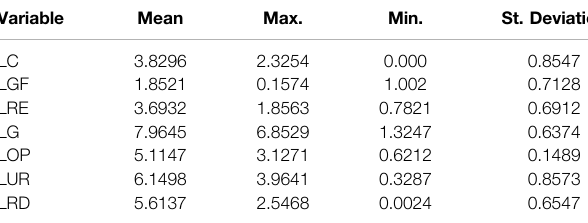
TABLE 1 | Descriptive statistics of variables.